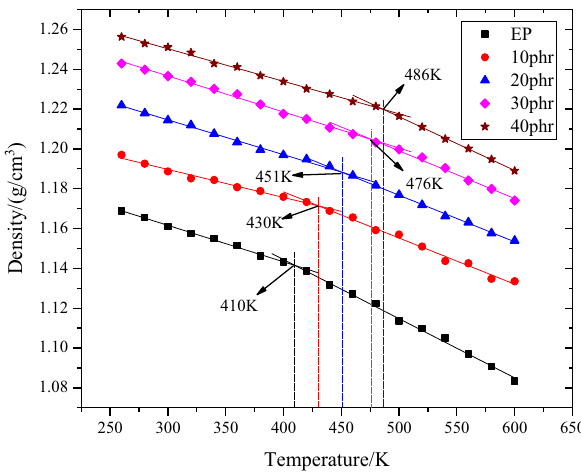
Figure 7: T g fi tting results of EP composites with di ff erent h - BN content.